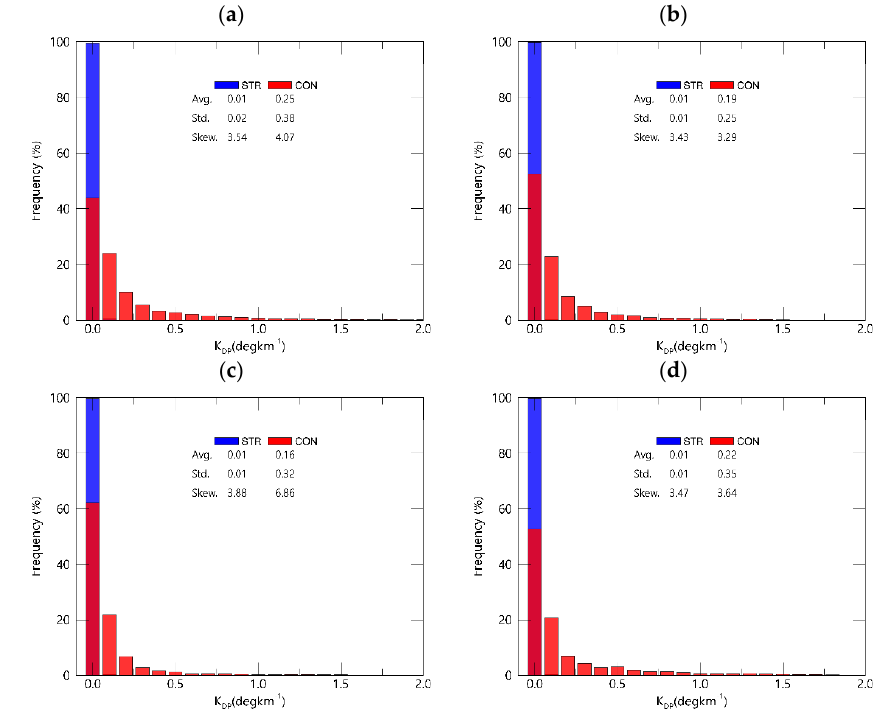
Figure 14. The occurrence frequency of specific differential phase with rain types at ( a ) BOS, ( b ) BUS, ( c ) CPO, and ( d ) JIN site. The blue represents stratiform rain and the red represents convective rain. The legend shows the average (Avg.), standard deviation (Std.), and skewness (Skew) of specific differential phase for both rain types.